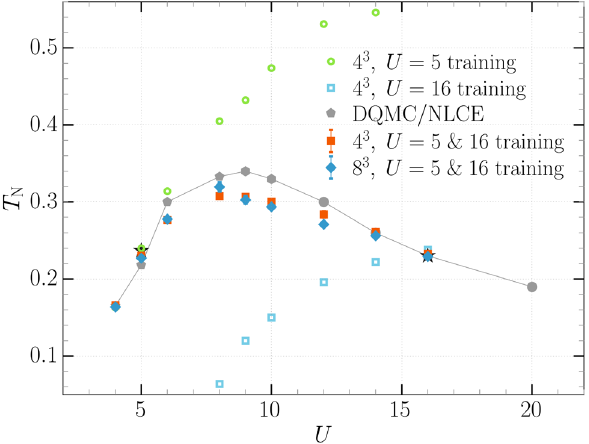
FIG. 2. Prediction of the Néel transition temperature by the neural network. Using the auxiliary spin configurations, the network is trained separately at U ¼ 5 and U ¼ 16 for N ¼ 4 3 , and simultaneously at U ¼ 5 and 16 for N ¼ 4 3 and N ¼ 8 3 . The error bars are the standard error of the mean of six different classifications using CNNs that were trained starting from different random weights and biases. The critical temper- atures used for the training of the network with N ¼ 4 3 are shown as stars (see text). Grey filled symbols are the estimates for T N in the thermodynamic limit from DQMC and NLCE simulations. Grey pentagons, hexagons, and circles for weak-, intermediate-, and strong-coupling regimes are taken from Refs. [18,19,21], respectively. The solid line is a guide to the eye.